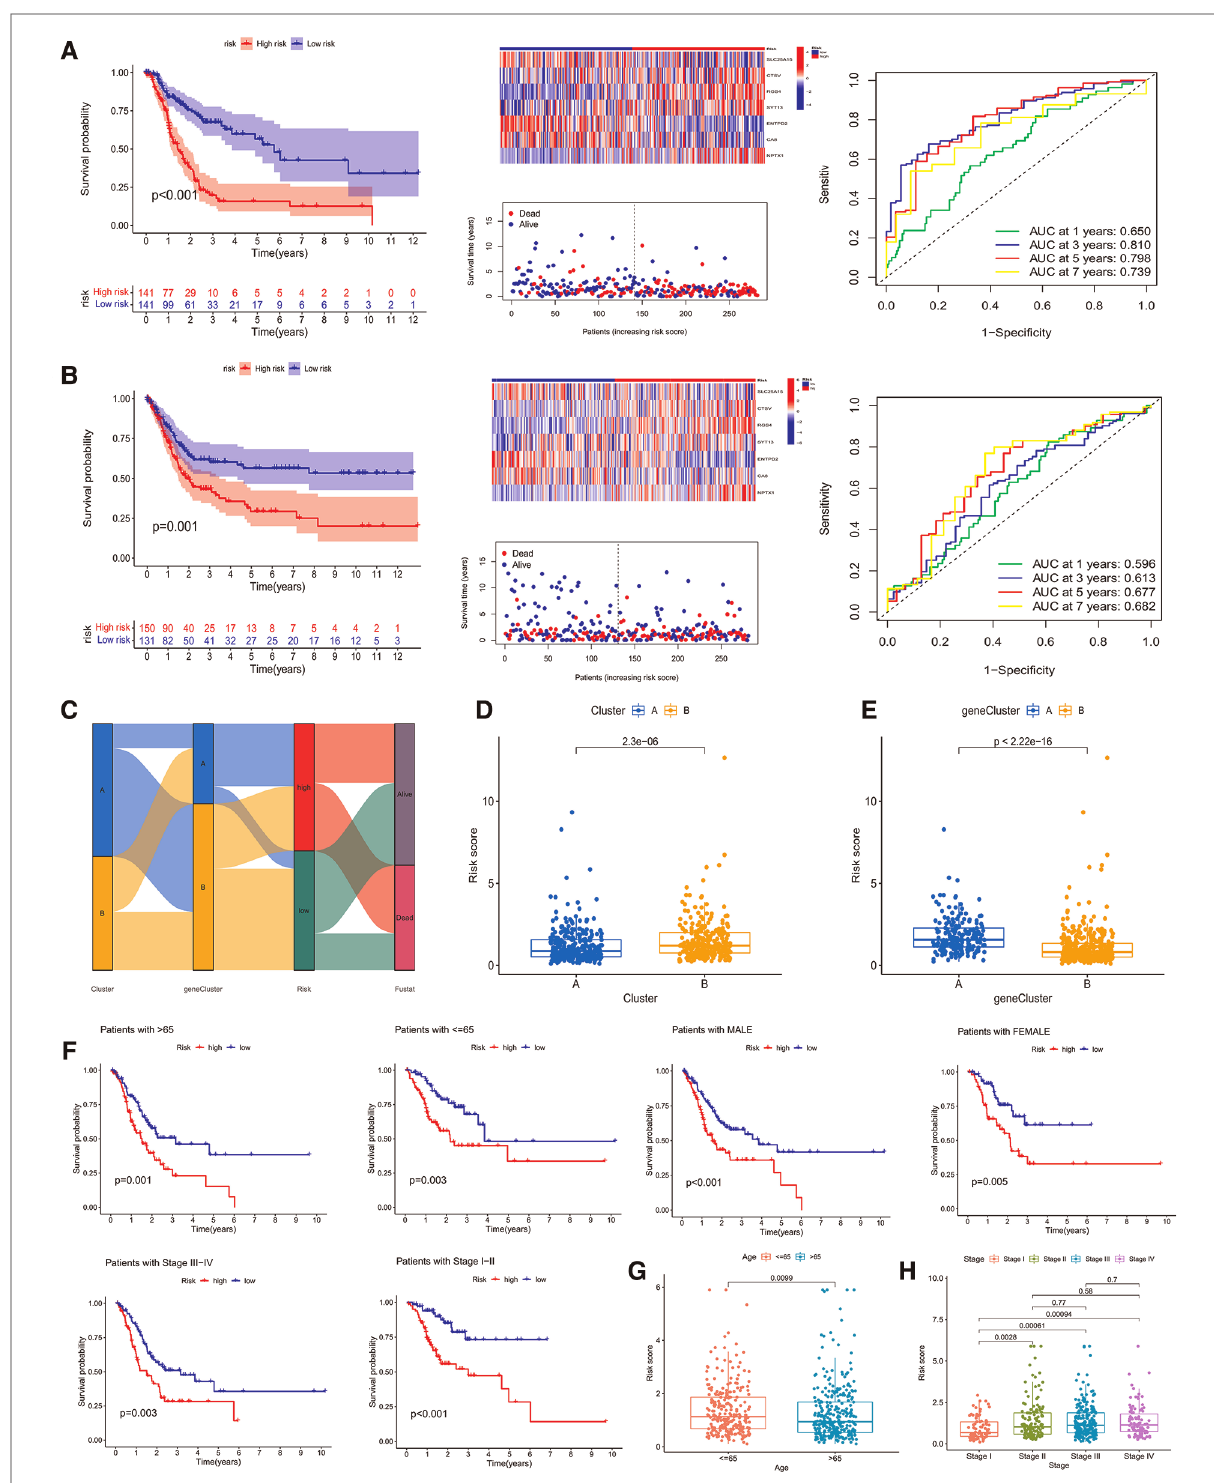
FIGURE 6 survival analysis, heatmap, survival status accompanied with the CRG_score and ROC analysis in the train cohort ( A ) and the test cohort ( B ). ( C ) Sankey picture showing the relationship of subtypes, geneclusters, risk groups and patients survival status. ( D,E ) Correlation of two subtypes and genecluster and CRG_score, respectively. ( F ) Applicability of CRG_score to GC patients of any age, gender and stage. ( G,H ) Relationship of age and stage with CRG_score,